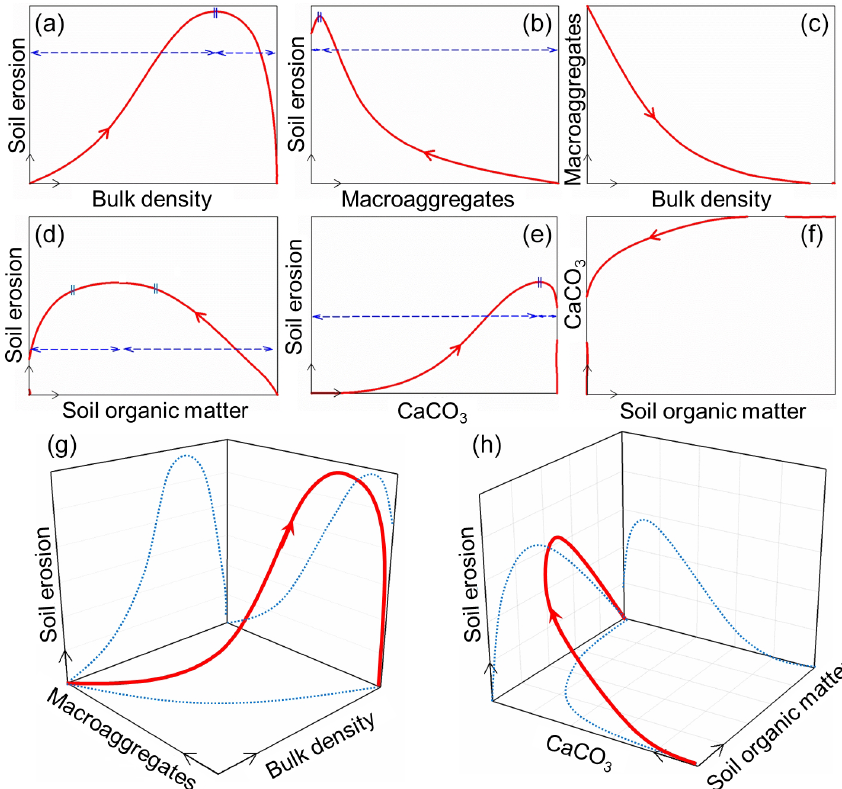
Figure 8. Examples of conceptual 2-D and 3-D phase diagrams linking soil erosion intensity with (a, b, g) bulk density and macroaggregate content and (d, e, h) SOM and CaCO 3 contents during agropedogenesis. The original curves were taken from Fig. 6. Small red arrows on curved lines show the direction of soil degradation and correspond to the increasing duration or intensity of agricultural use. Vertical blue double lines show the arbitrary thresholds of soil degradation, and horizontal blue dashed arrows show the degradation stages. The stages are time-lapse to reach a threshold for a given soil property. After a threshold the trend may slow down or reverse. Projections of 3-D lines (light blue) in (g, h) correspond to the individual lines on the 2-D phase diagrams in (a) – (c) and (d) – (f) . Similar phase diagrams can be built in multidimensional space corresponding to the number of master soil properties (Table